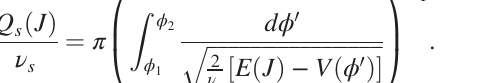
Þ . At the optimal =r 2 o